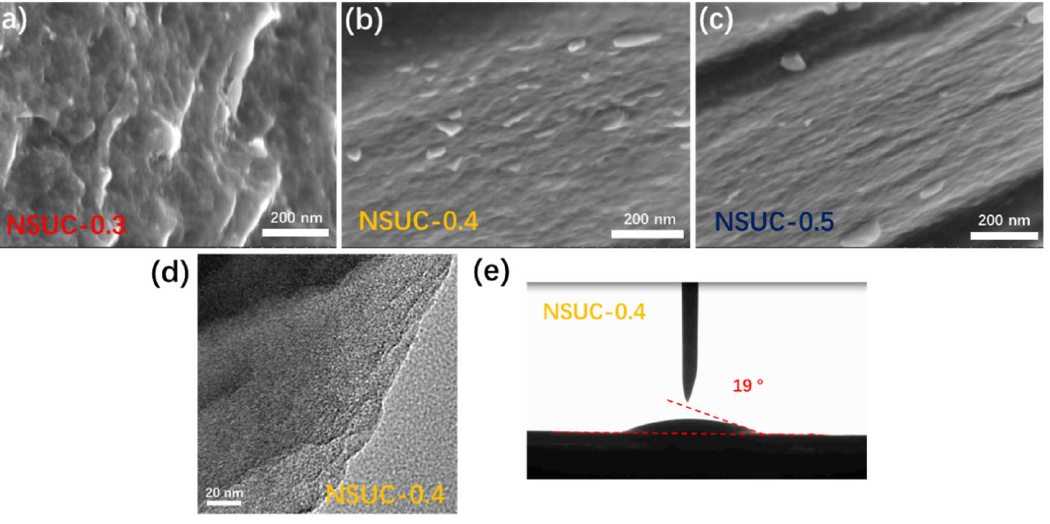
Figure 4. ( a – c ) SEM images of NSUC-x, ( d ) TEM images of NSUC-0.4, and ( e ) the contact angle of water on the surface of NSUC-0.4.